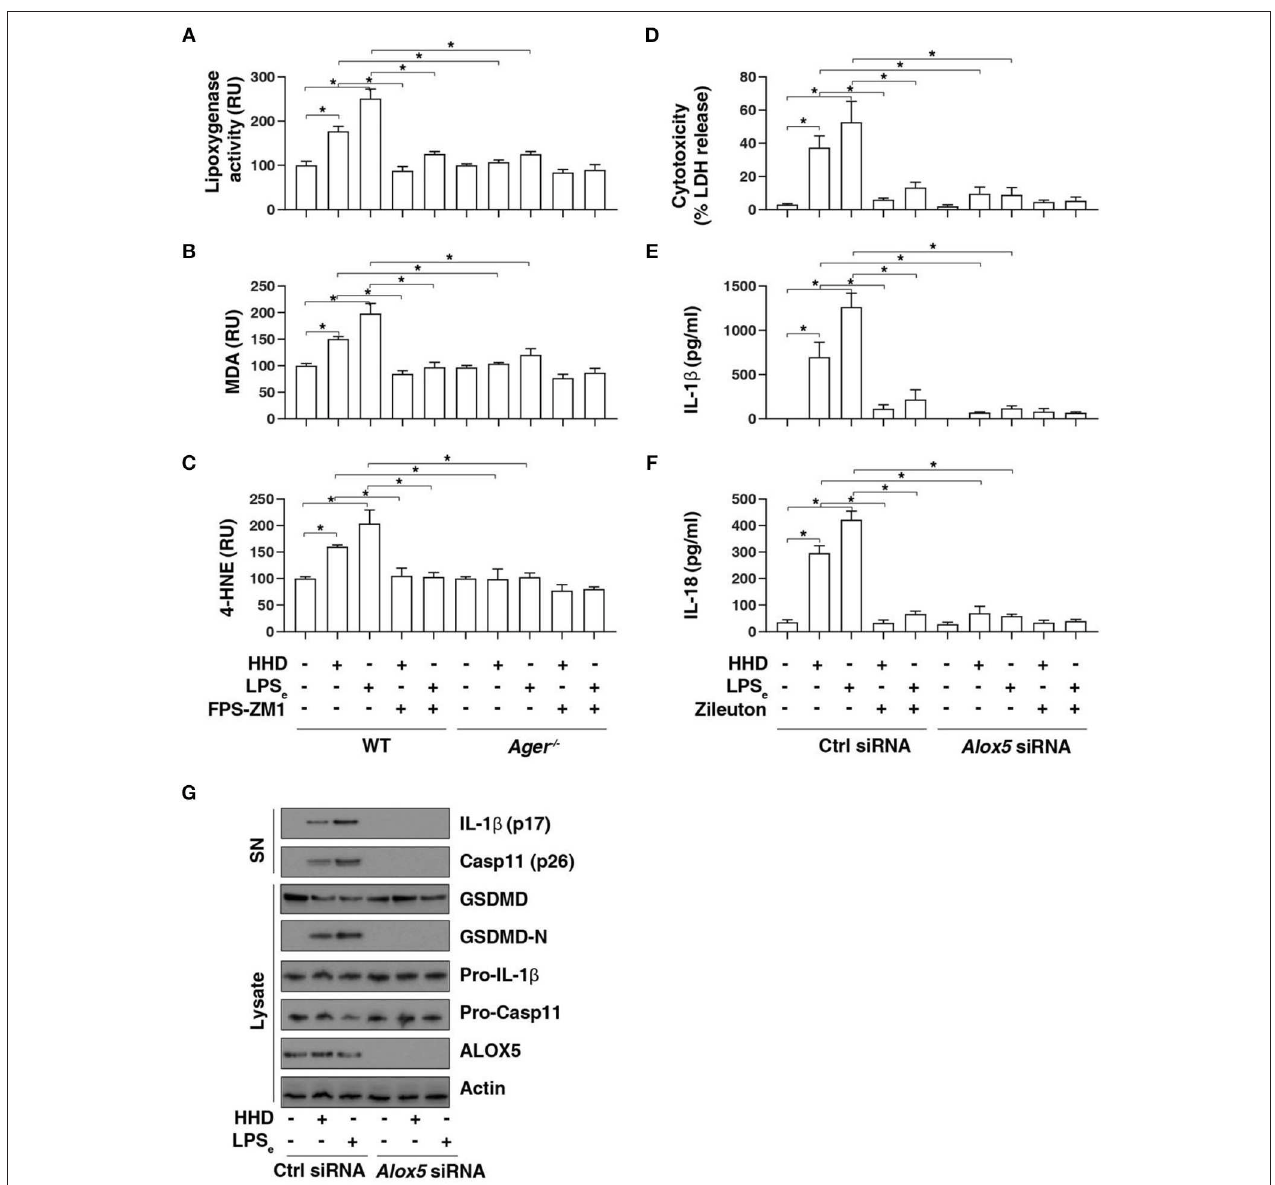
FIGURE 4 | AGER-mediated lipid peroxidation promotes caspase-11 inflammasome activation. (A–C) Analysis of lipoxygenase activity (A) , MDA level (B) , and 4-HNE level (C) in indicated LPS-primed BMDMs after HHD treatment (500ng/ml, 16h) or LPS electroporation (LPS e ; 1 µ g, 16h) in the absence or presence of FPS-ZM1 (1 µ M). n = 3, data expressed as means ± SD of three independent experiments, * P < 0.05, t test. (D–F) Analysis of cytotoxicity (D) , IL-1 β release (E) , and IL-18 release (F) in indicated LPS-primed BMDMs after HHD treatment (500ng/ml, 16h) or LPS electroporation (LPS e ; 1 µ g, 16h) in the absence or presence of zileuton (5 µ M). n = 3, data expressed as means ± SD of three independent experiments, * P < 0.05, t test. (G) Western blot analysis of indicated proteins in the supernatant (SN) or cell lysate in LPS-primed BMDMs after HHD treatment (500ng/ml, 16h) or LPS electroporation (LPS e ; 1 µ g, 16h). Western blot data represent two independent